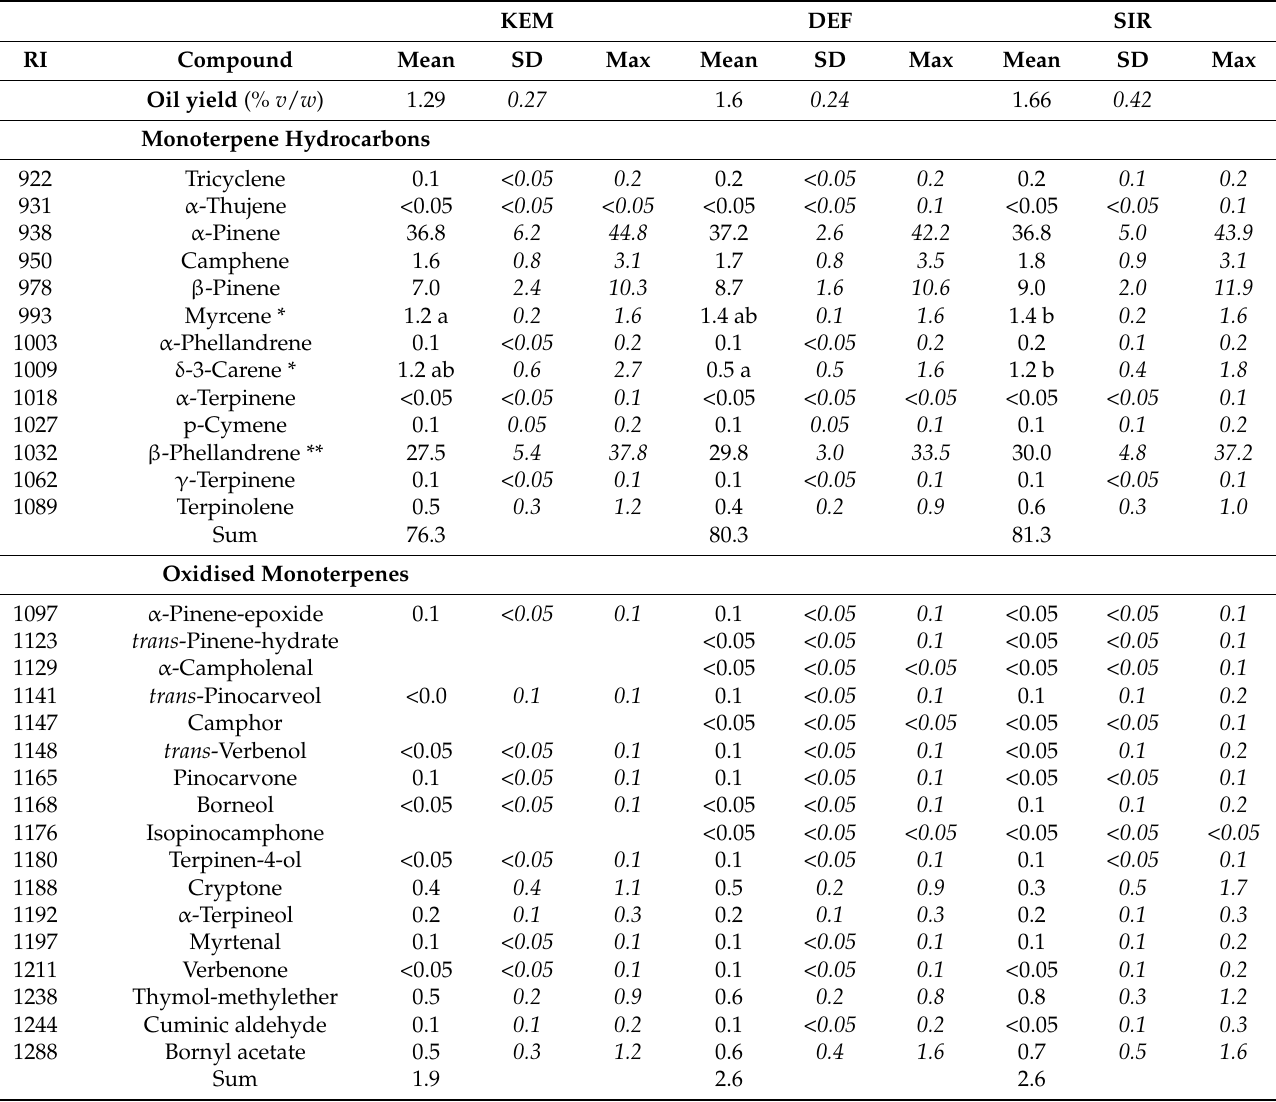
Table 1. Composition of the essential oil (%) from Pinus cembra